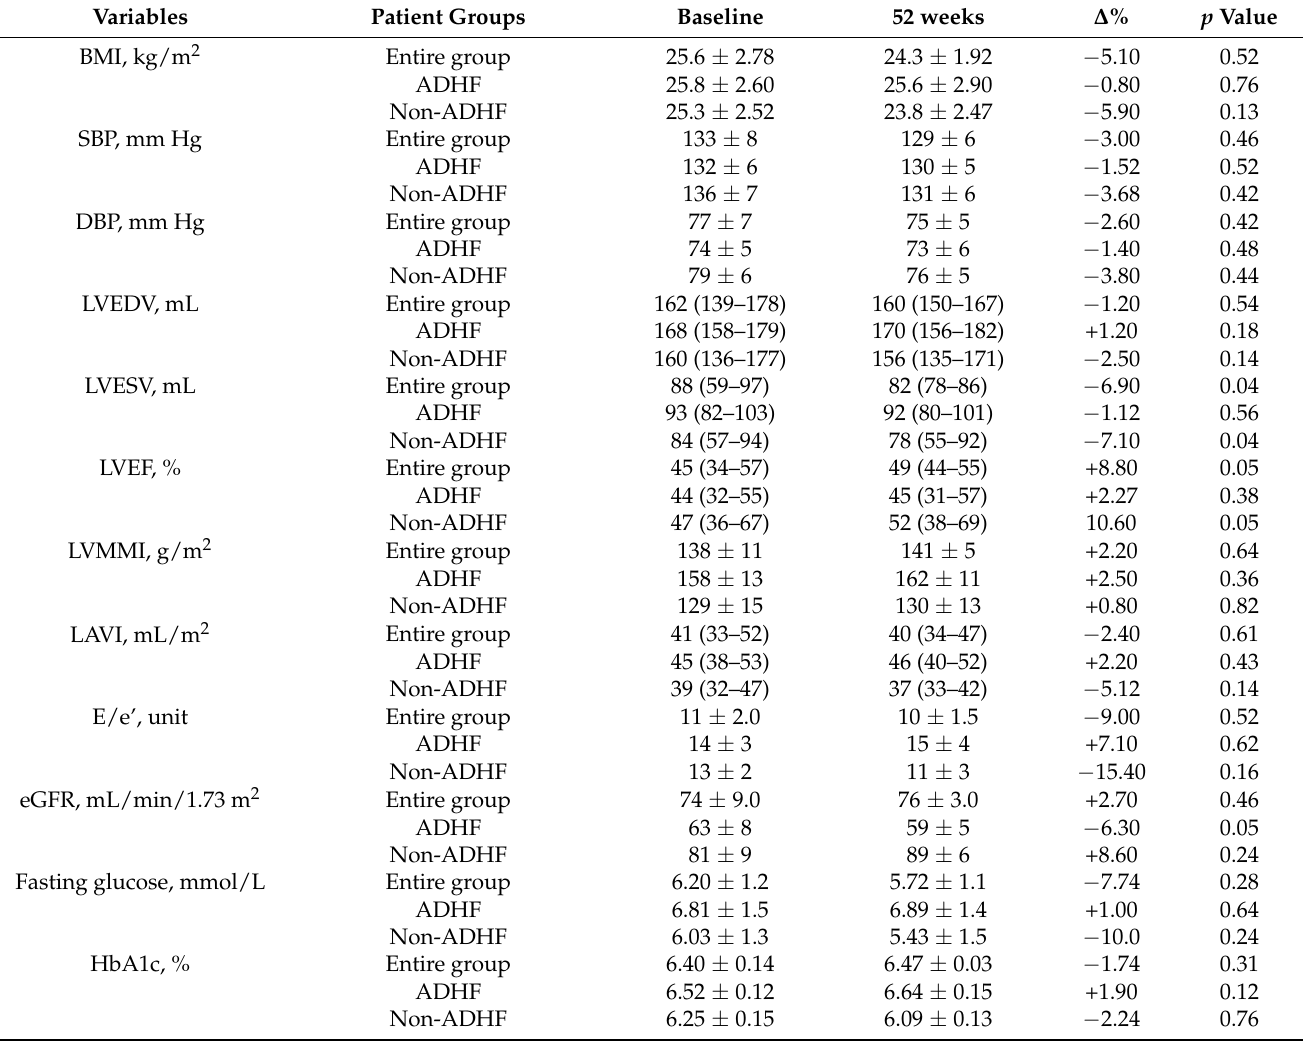
Table 2. Comparison of variables between baseline and 52 weeks after the administration of